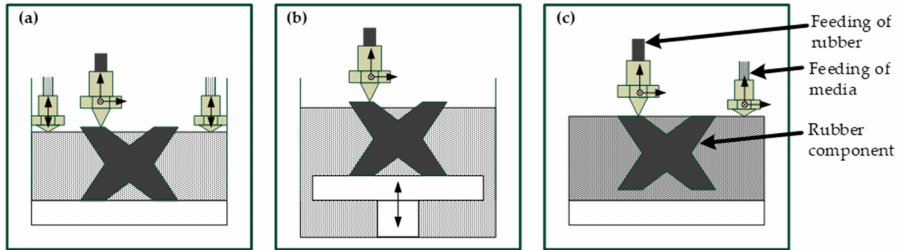
Figure 1. Possible variants of 3D printing process for rubber components with media for dimensional stabilization (MDS): ( a ) feeding a liquid medium via two vertically movable nozzles, ( b ) lowering of printed rubber layers into a liquid medium, and ( c ) feeding of a solid medium via a 3-axis movable